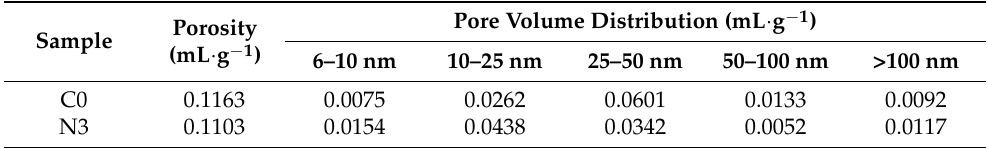
Table 5. MIP results of 28 d cured samples C0 and N3.